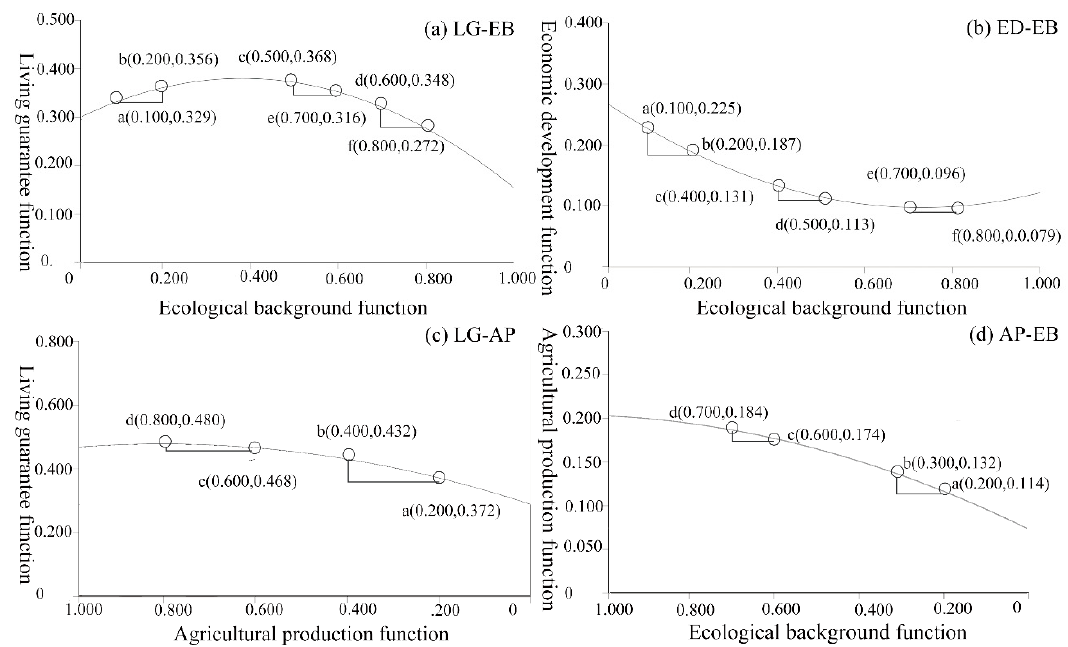
Figure 4. PPF curves among multiple rural functions in Yongchang County: ( a ) the trade-off combination of living guarantee function and ecological background function; ( b ) the trade-off combination of economic development function and ecological background function; ( c ) the trade-off combination of living guarantee function and agricultural development function; ( d ) The trade-off combination of agricultural development functions and ecological background functions.